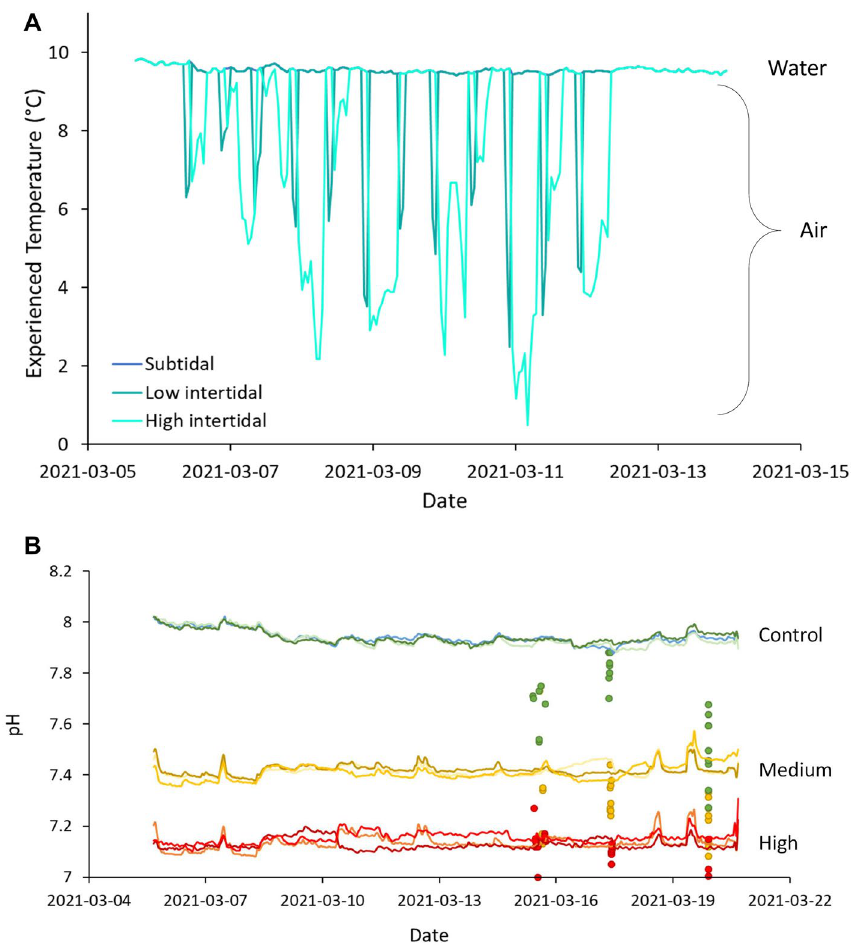
Figure 3. Temperature and pH experienced by the herring embryos and larvae throughout the experiment. Hourly measurements of ( A ) air/water temperature experienced by herring embryos in each of the tidal treatments (subtidal: continuous immersion in 9.5 °C water; low intertidal: 2 × 2 h air exposure; high intertidal: 5 + 9 h air exposure) and ( B ) pH levels in the tanks for each of the CO 2 treatments (greens = control, 400 µatm CO 2 , yellows = medium, 1600 µatm CO 2 , reds = high, 3000 µatm CO 2 ); dots are pH levels measured in the individual jars during larval incubation.